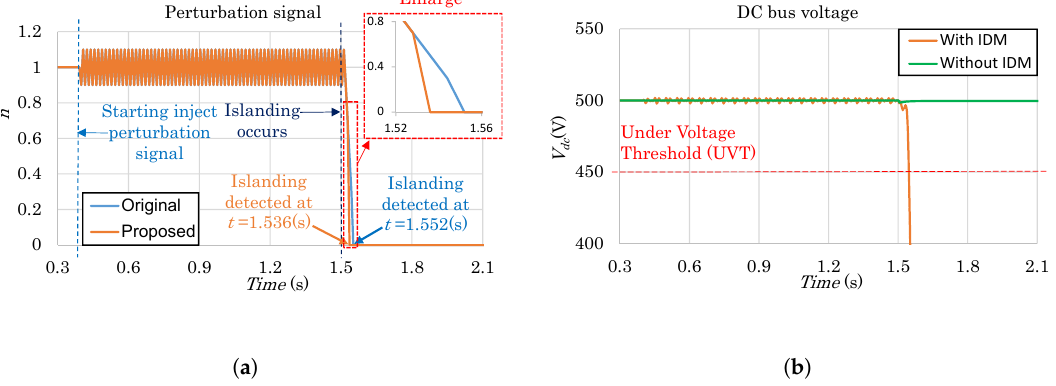
Figure 13. Result in case of multi-PV operation, 200 kW PV, hardest islanding condition (case 1): ( a ) Perturbation signal and ( b ) DC bus voltage (with and without